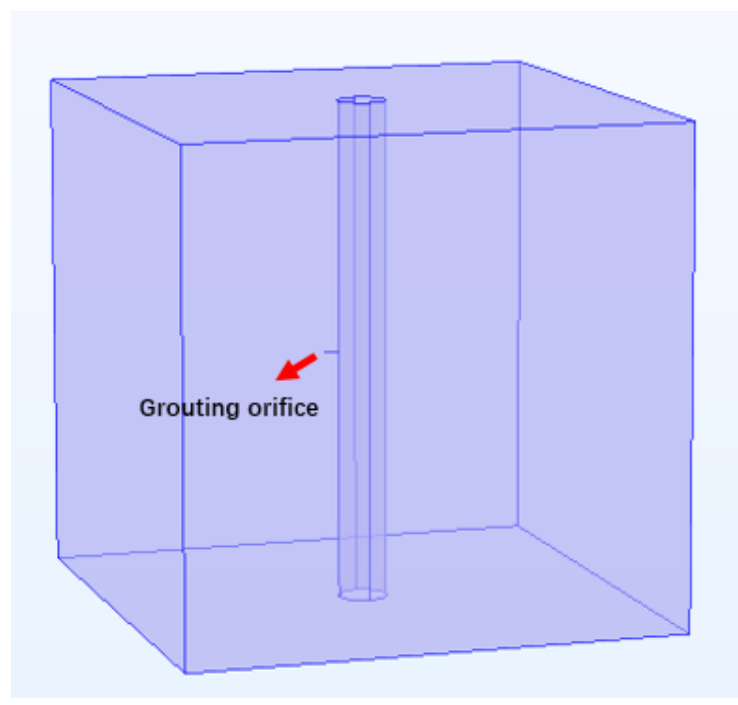
Figure 6. Results for no-flow boundary selection.